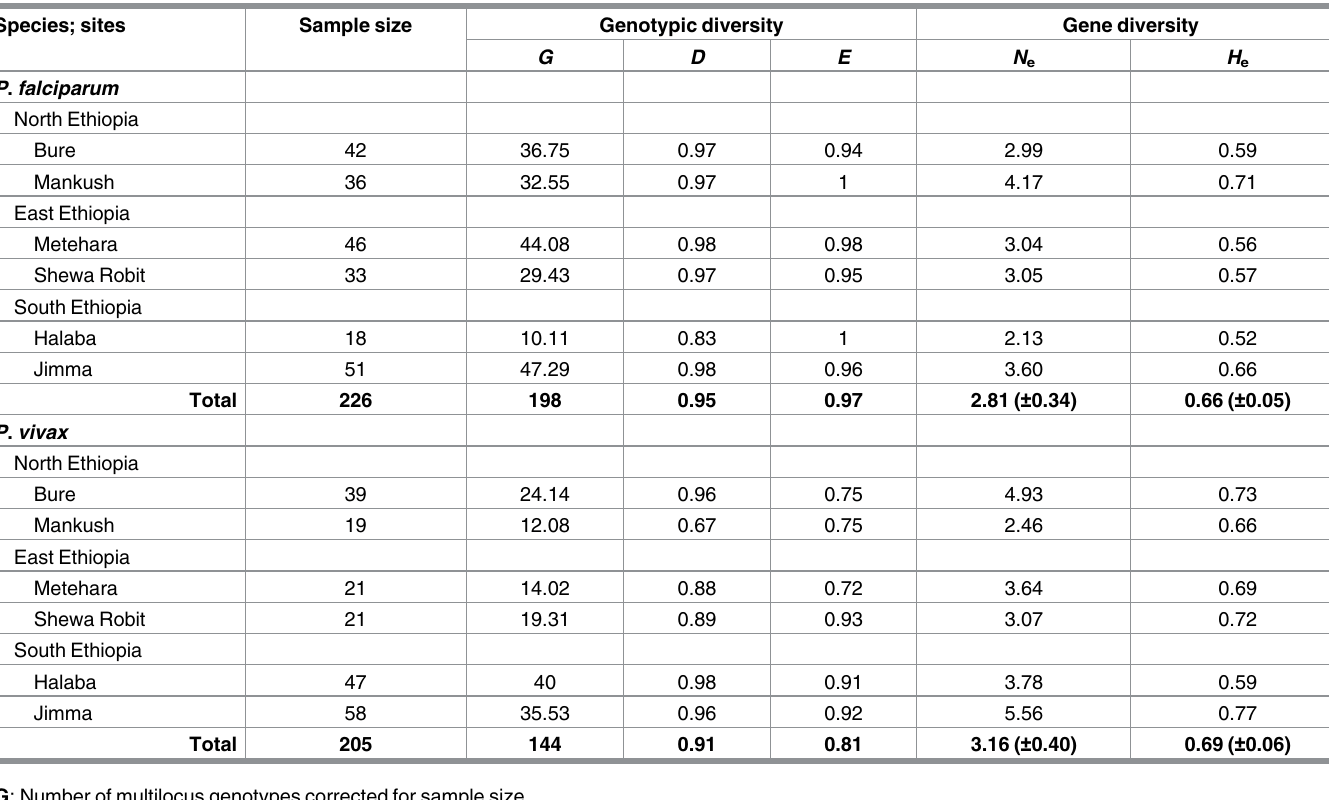
Table 2. Comparison of Plasmodium falciparum and P . vivax genetic diversity measuresbased on microsatellite markers. Species;